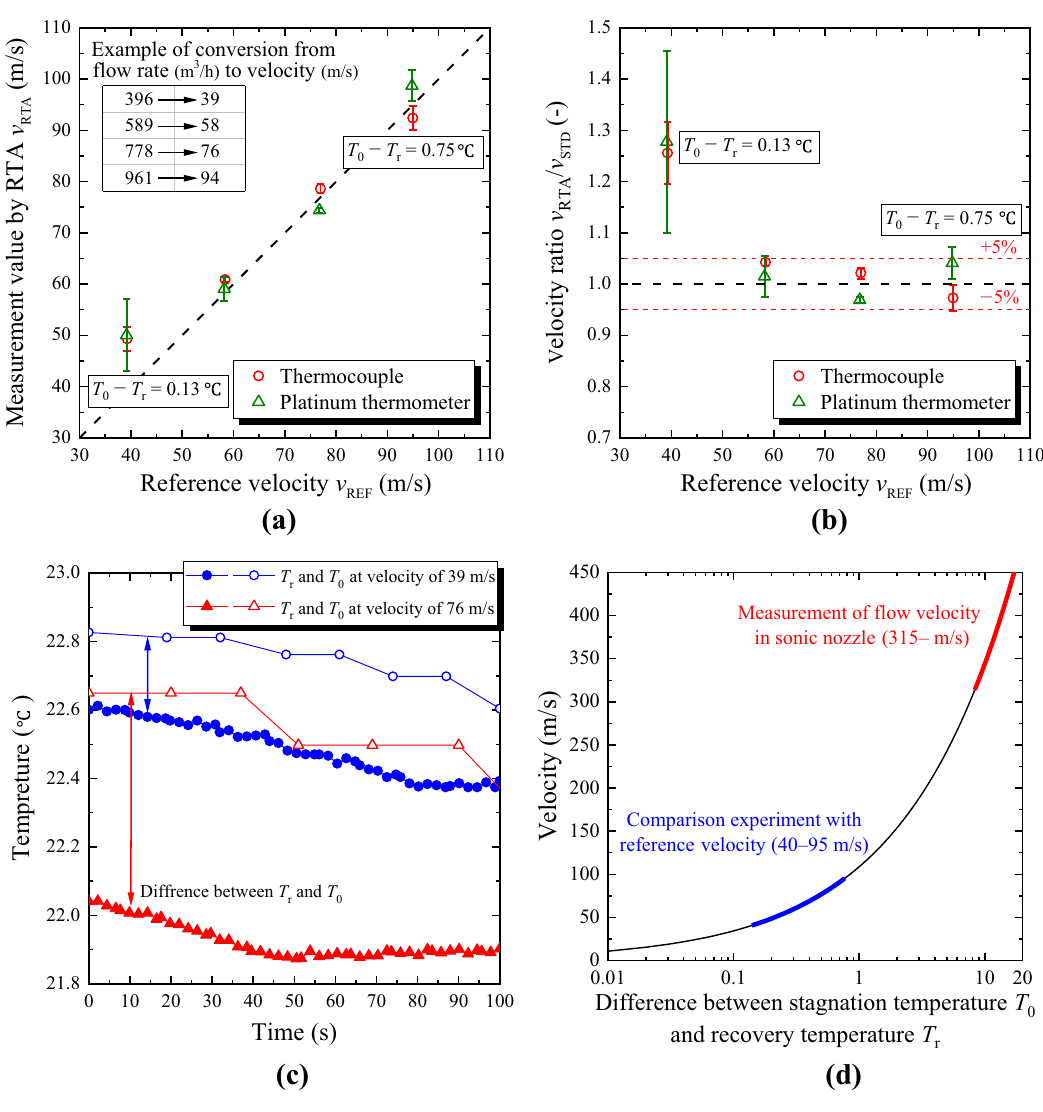
Figure 3. Experimental results comparing RTA with reference velocity. Experiments were performed three times under the same conditions. The plots show the mean values, and the error bars show the standard errors. ( a ) Comparison between v REF and v RTA based on absolute values. The upper left part of the graph shows an example of the conversion from the flow rate to the standard velocity in this experiment. The difference between T 0 and T r is provided for reference under the conditions of flow velocities of approximately 40 m/s and 90 m/s. ( b ) Comparison between v REF and v RTA based on ratios. The red dashed line indicates the difference of ± 5% from the reference velocity. ( c ) Time variation of T 0 and T r measured using platinum thermometers at flow velocity of 39 and 76 m/s. ( d ) Relationship between the temperature difference between T 0 and T r and the flow velocity. The specific heat of constant pressure C p and the recovery temperature coefficient r are set to 1006 (J kg −1 K −1 ) and 0.83, respectively. The relationship was calculated using Eq. (3). The velocity ranges of the two experiments conducted in this study are also Accuracy of flow velocity measurement by RTA . Figure 3a,b illustrate the relationship between the reference velocity v REF and the value measured by RTA v RTA based on absolute values and ratios, respectively. Figure 3b shows that the maximum difference between v REF and v RTA is approximately 30% when the flow veloc- ity is approximately 40 m/s. The standard error of v RTA is also larger than that of the other velocity points. It is considered that the accuracy of temperature measurement affects the measurement accuracy of RTA, and the difference between T 0 and T r is as small as approximately 0.13 °C at approximately 40 m/s. In the velocity range of 60–90 m/s, the temperature difference between T 0 and T r increases to approximately 0.75 °C, and the differ- ence between v REF and v RTA is within 5% for both the thermocouple and platinum thermometer. Therefore, in the range of large flow velocities where the temperature difference between T 0 and T r increases, a high accuracy can be expected regardless of the type of thermometers. The standard error of v RTA for both the thermocouple and the platinum thermometer increased for v REF = 90 m/s compared to that for v REF = 75 m/s. This can be attributed